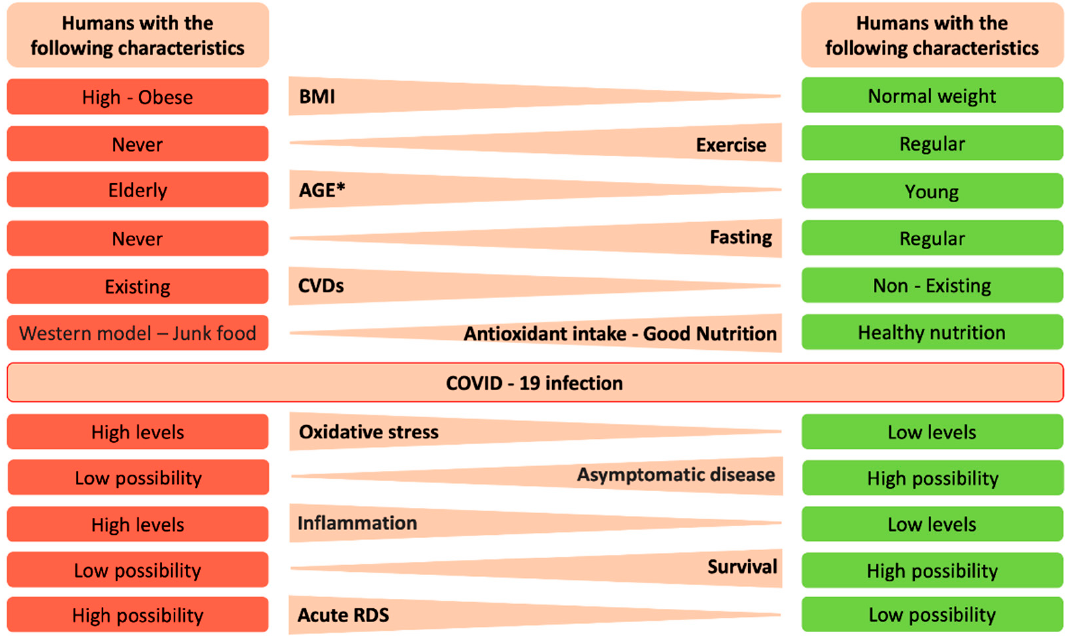
Figure 3. Human characteristics and potential outcomes after infection with severe acute respiratory syndrome coronavirus-2 (SARS-CoV-2). In this figure we summarize lifestyle characteristics and the underlying mechanisms as well as potential outcomes before or after SARS-CoV-2 infection. * In the present context age, young and old, means young or old in chronological age, but also could refer to young and old in terms of their lung health (i.e., a chronologically old person may have “young” physiological indices due to healthy lifestyle habits, and vice